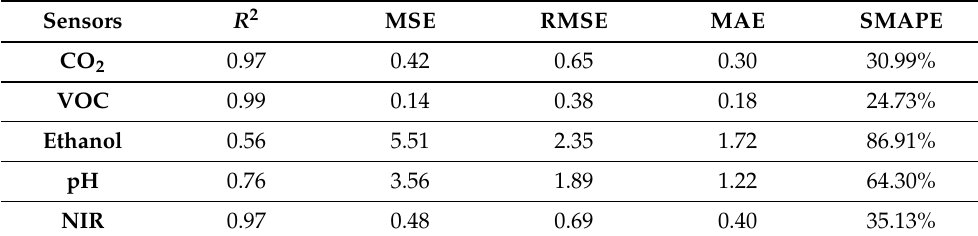
Table 6. Performance Metrics XGBoost